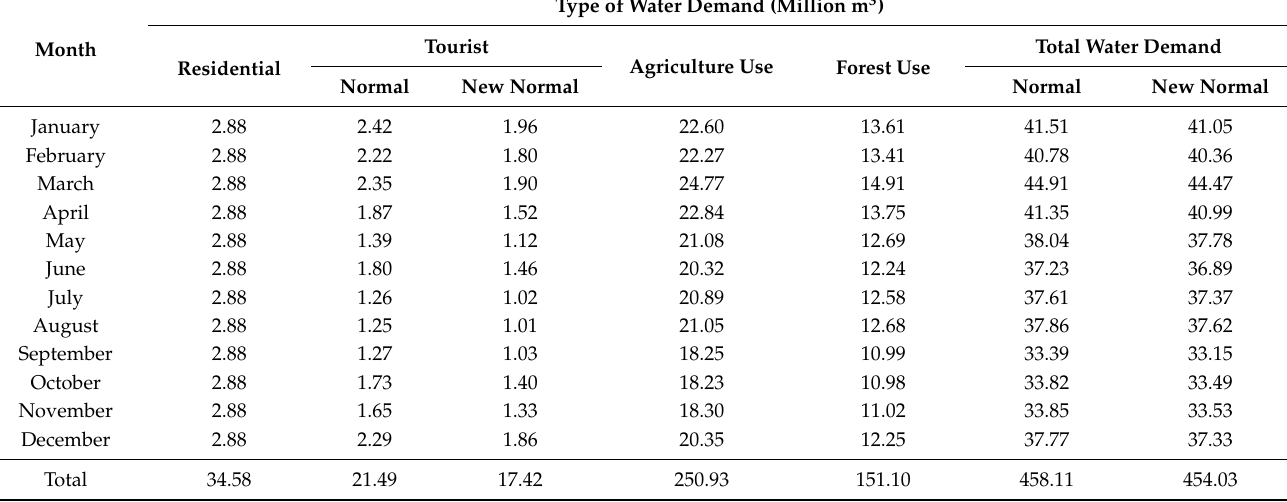
Table A5. Average monthly water demand estimation of each category between 2020 and 2029 under normal and new normal